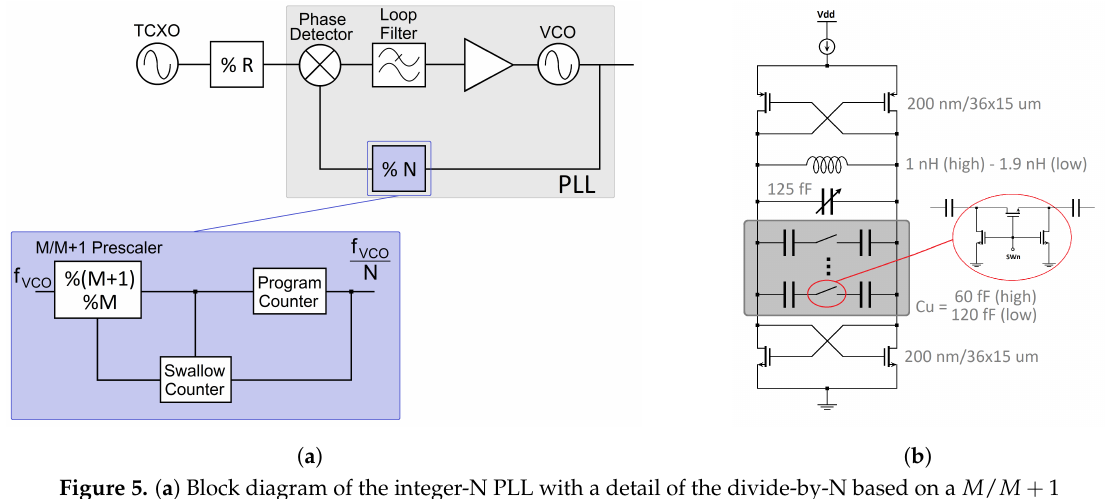
Figure 5. ( a ) Block diagram of the integer-N PLL with a detail of the divide-by-N based on a M / M + 1 program-swallow counter and ( b ) circuit diagram of the LC-VCO with a detail of the elements of the 7-level switched capacitor